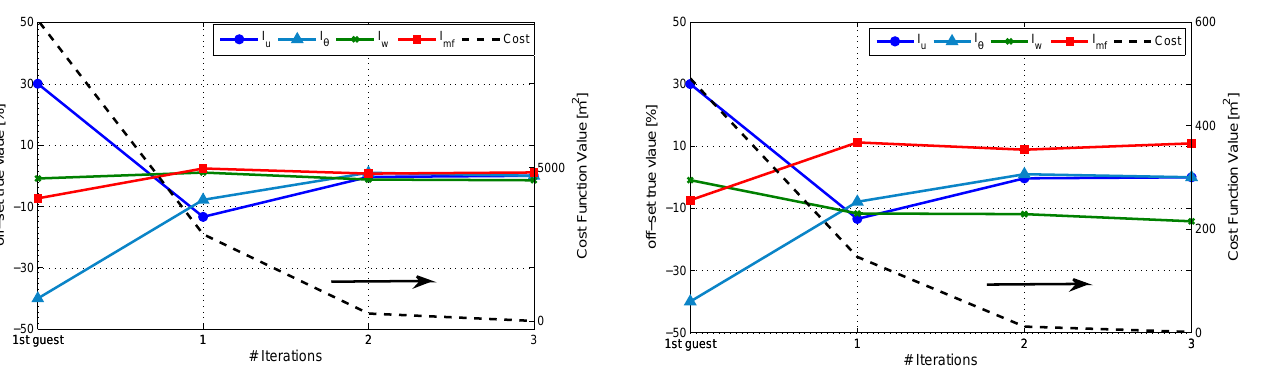
Figure 5. Convergence of cost function (dashed line, right axis) and individual convergence of each invariant to true value (solid line, left axis). Assimilation windows = 3min (1assimilationmin − 1